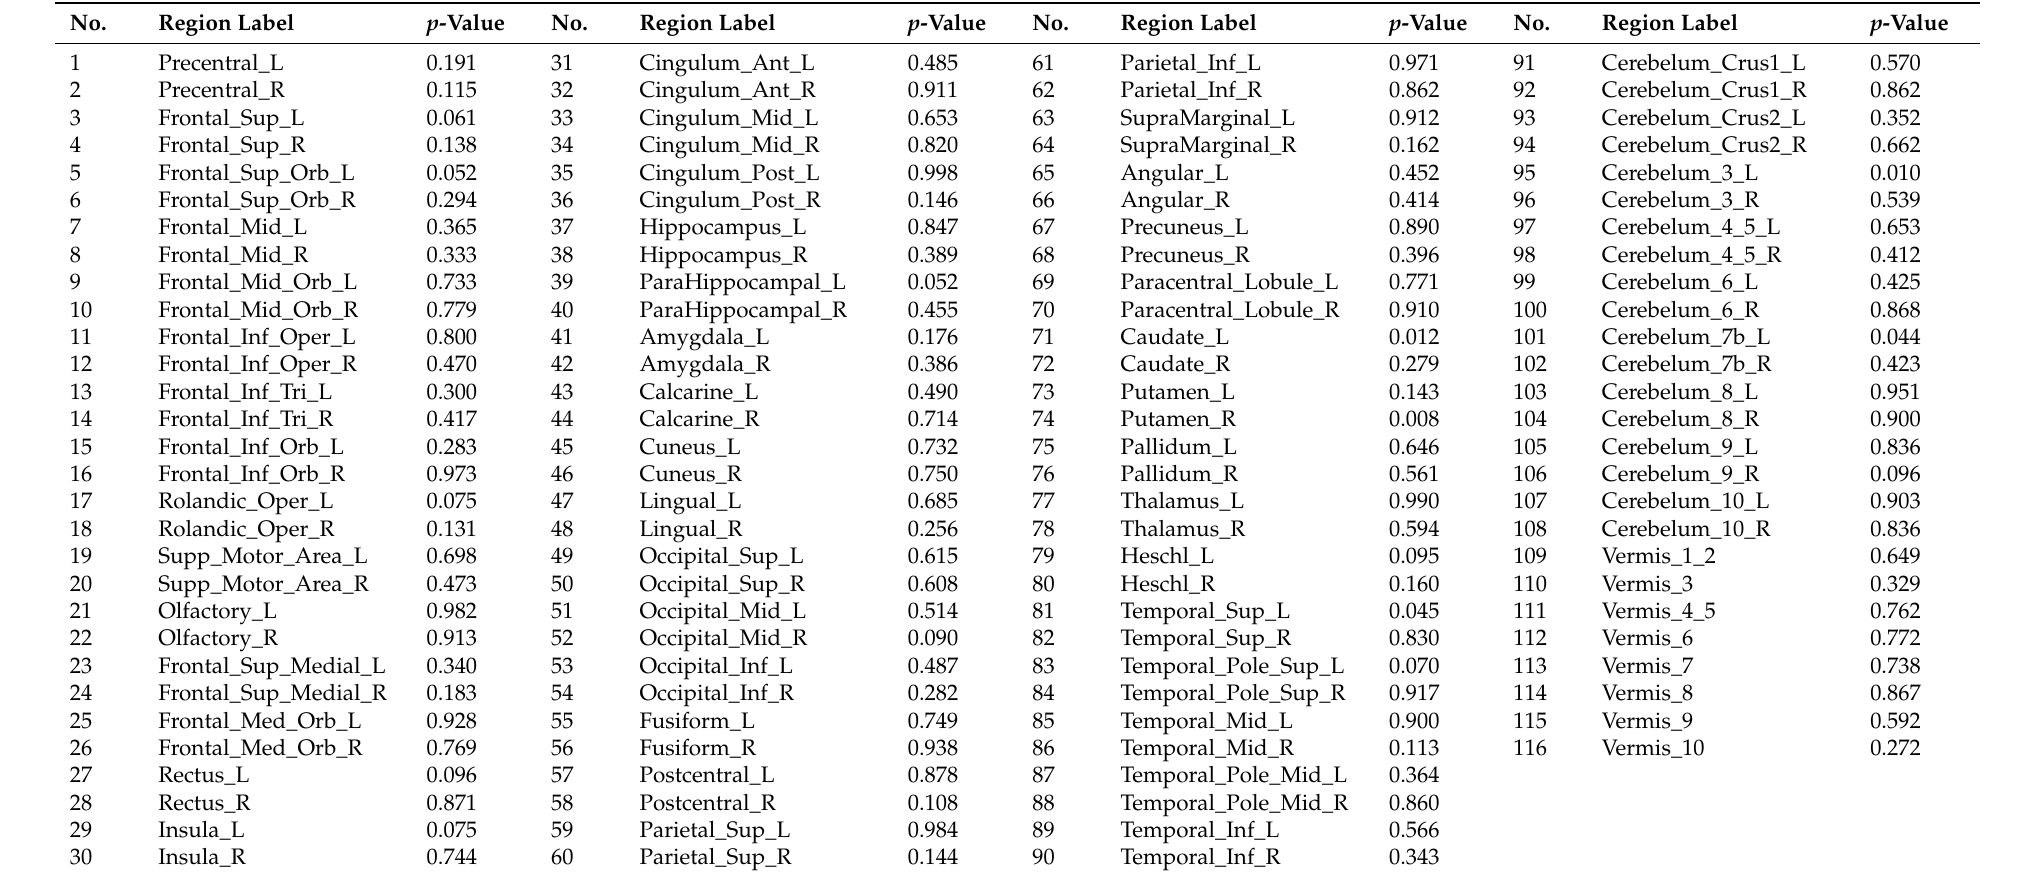
Table A1. p -Value for all brain nodes based on ANOVA